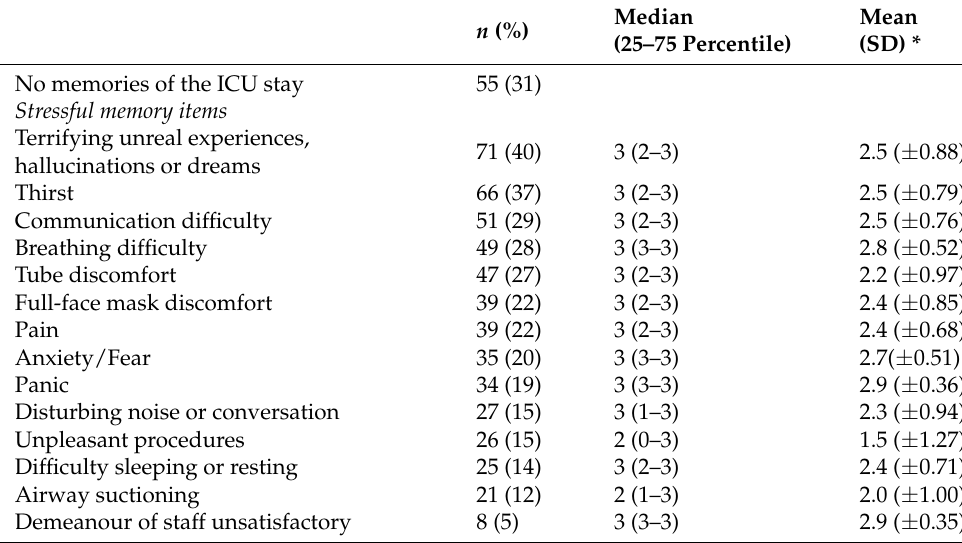
Table 2. Phase two. Frequency and ratings of stressful memories in intensive care patients by use of the 14-item checklist with 4 response categories (N =